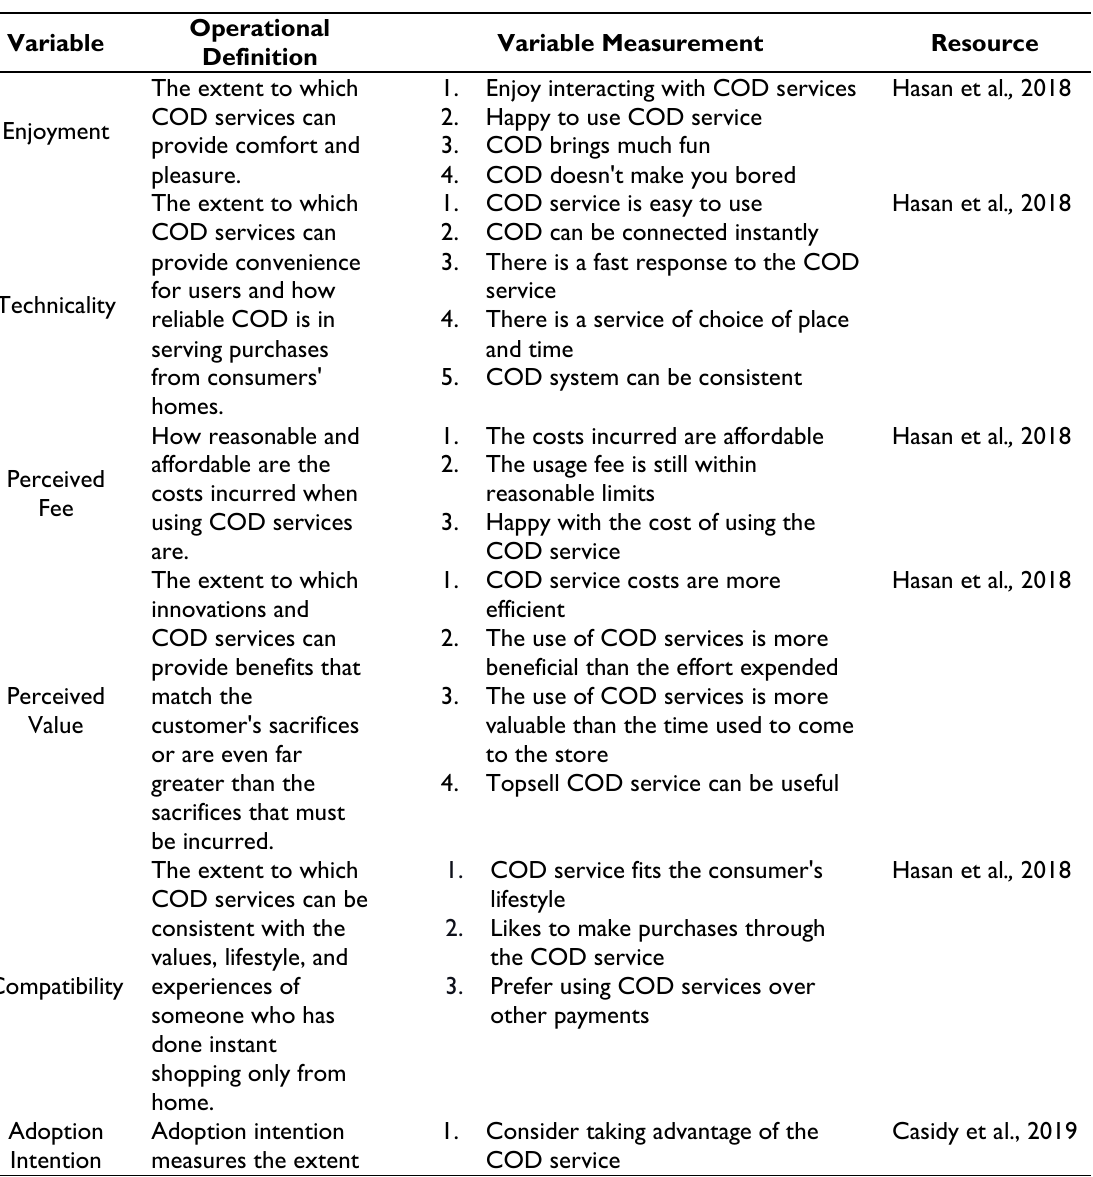
Table 1. Variable Operational Definition